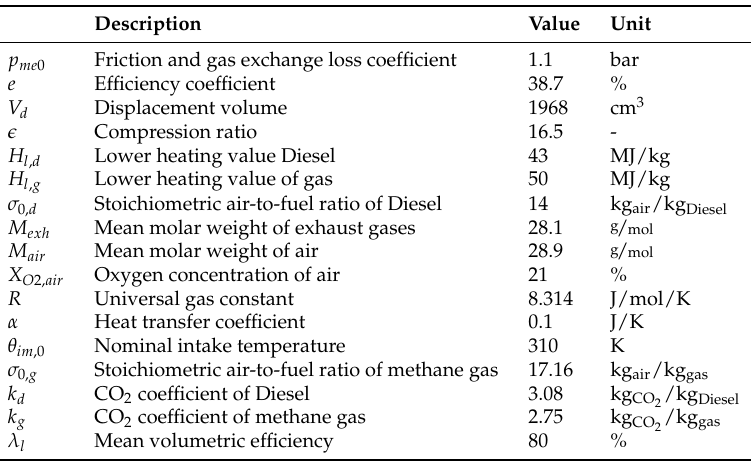
Table 8. Physical model parameters.